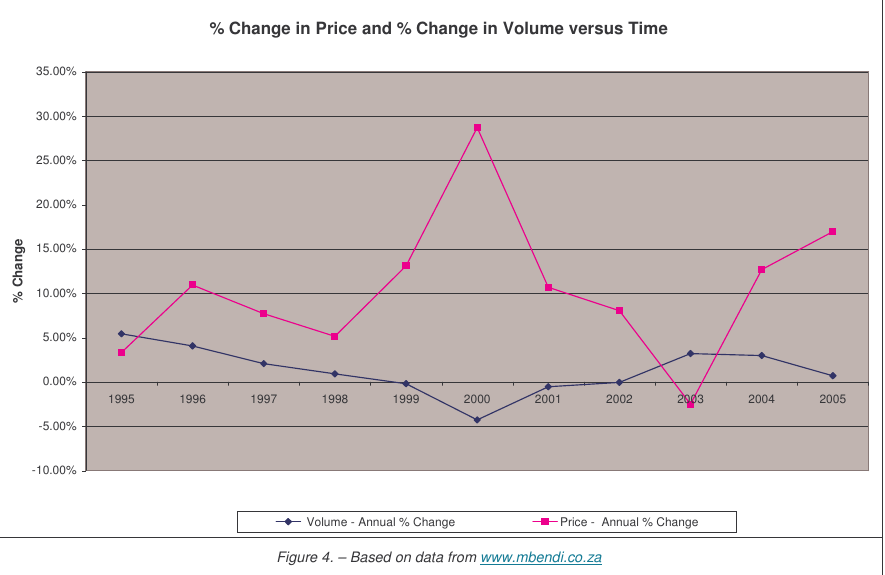
Figure 4: Percentage change in price and volume versus time % Change in Price and % Change in Volume versus